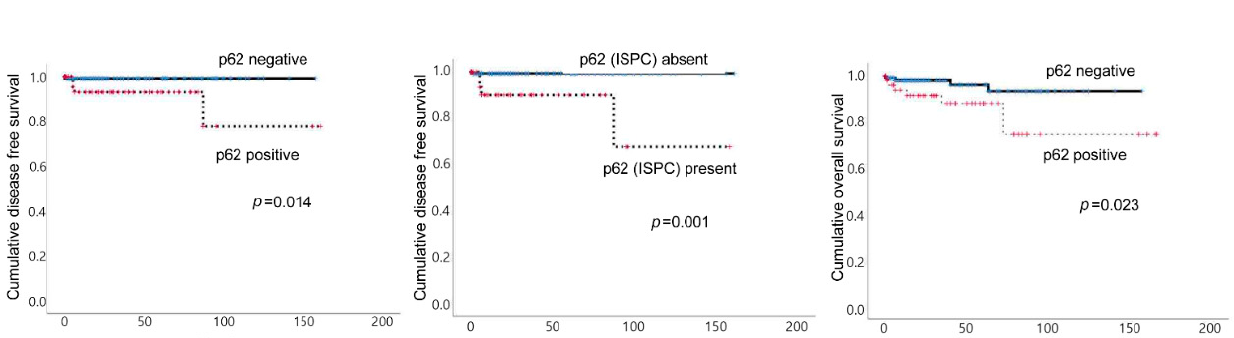
Table 4. Univariate analysis of the impact of expression of autophagy-related proteins in pheochromocytoma on disease- free survival and overall survival by the log-rank test.